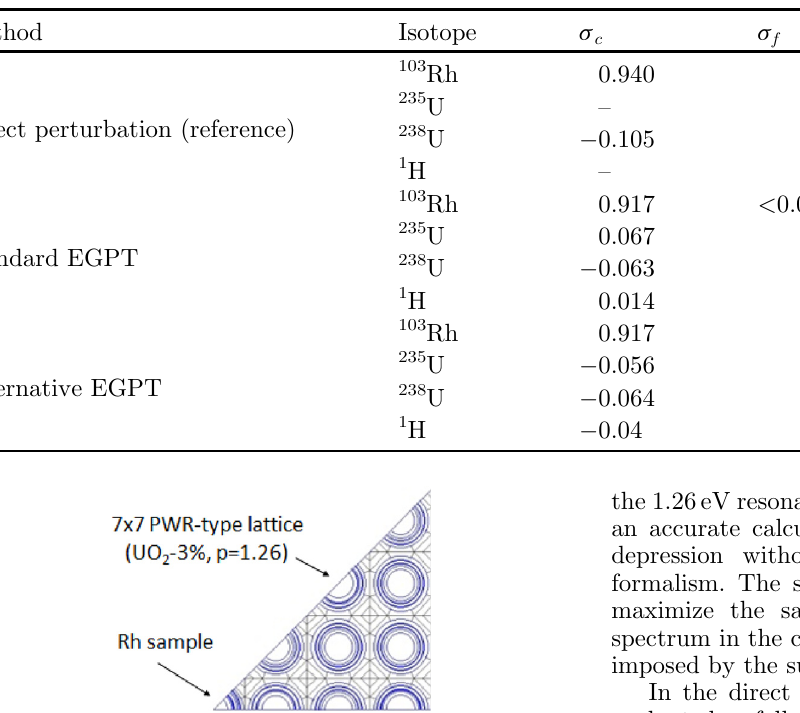
Table 1. Comparison of 1-group sensitivity coef fi cients between the two EGPT methods and the reference direct perturbation method.